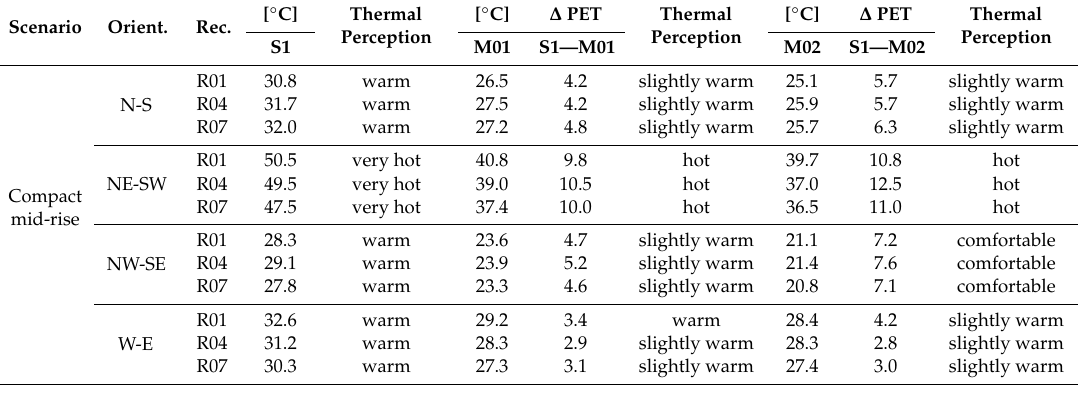
Figure 13. PET values registered in all 14 receptors in the compact mid-rise urban areas for scenario S1, M01 and M02 in all orientations. Table 15. Peak values of PET, for R01 (at the beginning of the urban canyon), R04 (in the middle) and R07 (at the end) in compact mid-rise urban areas for scenario S1, mitigation scenario M01 and M02. Scenario Orient. Rec.